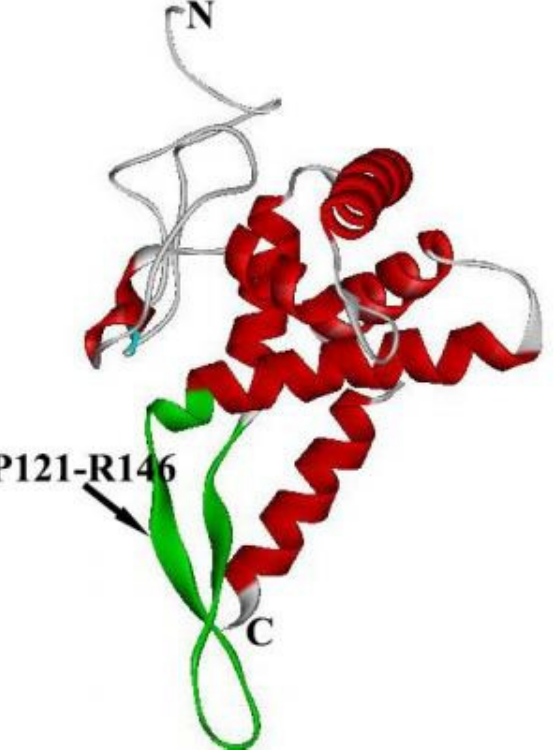
Figure 6. Crystal structure of Homo RPS5 is separated from the structure of Homo 40S using software of chimera. The green fragment is P121-R146.